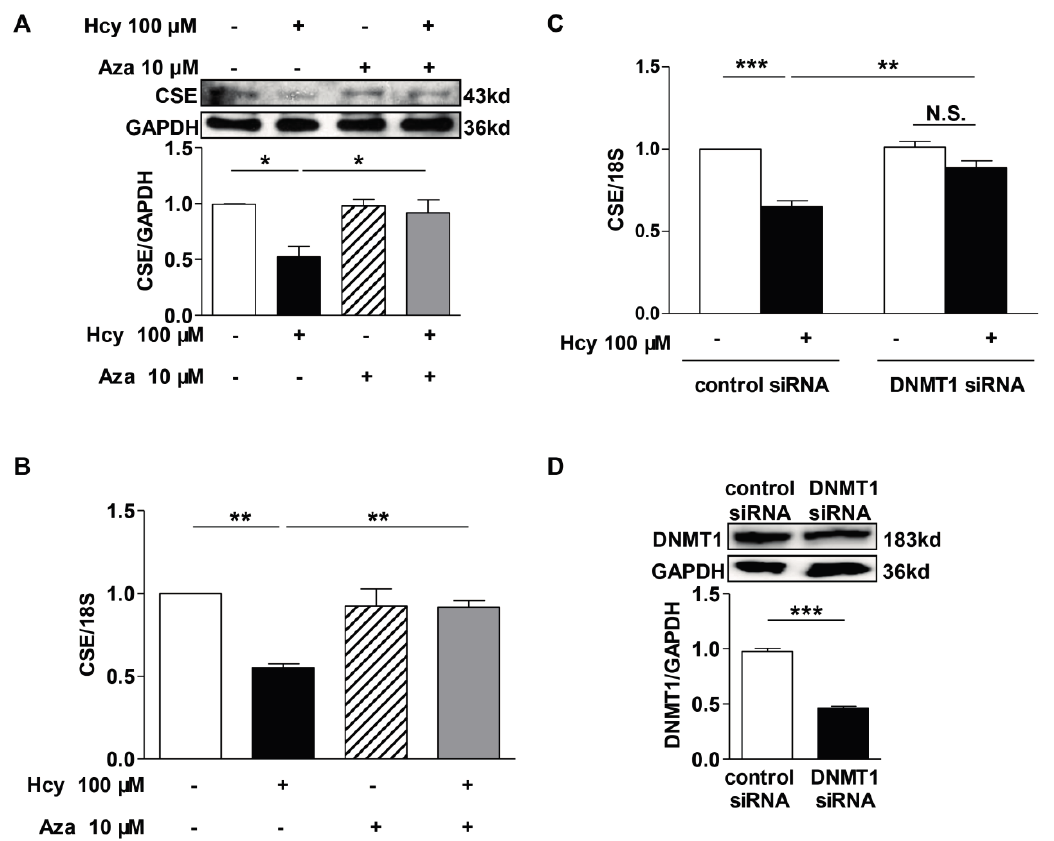
Figure 5. DNMTs inhibition reversed the repression of Hcy on CSE expression. DNMTs inhibition with its inhibitor Aza ( A , B ) or DNMT1 siRNA ( C ) almost reversed the